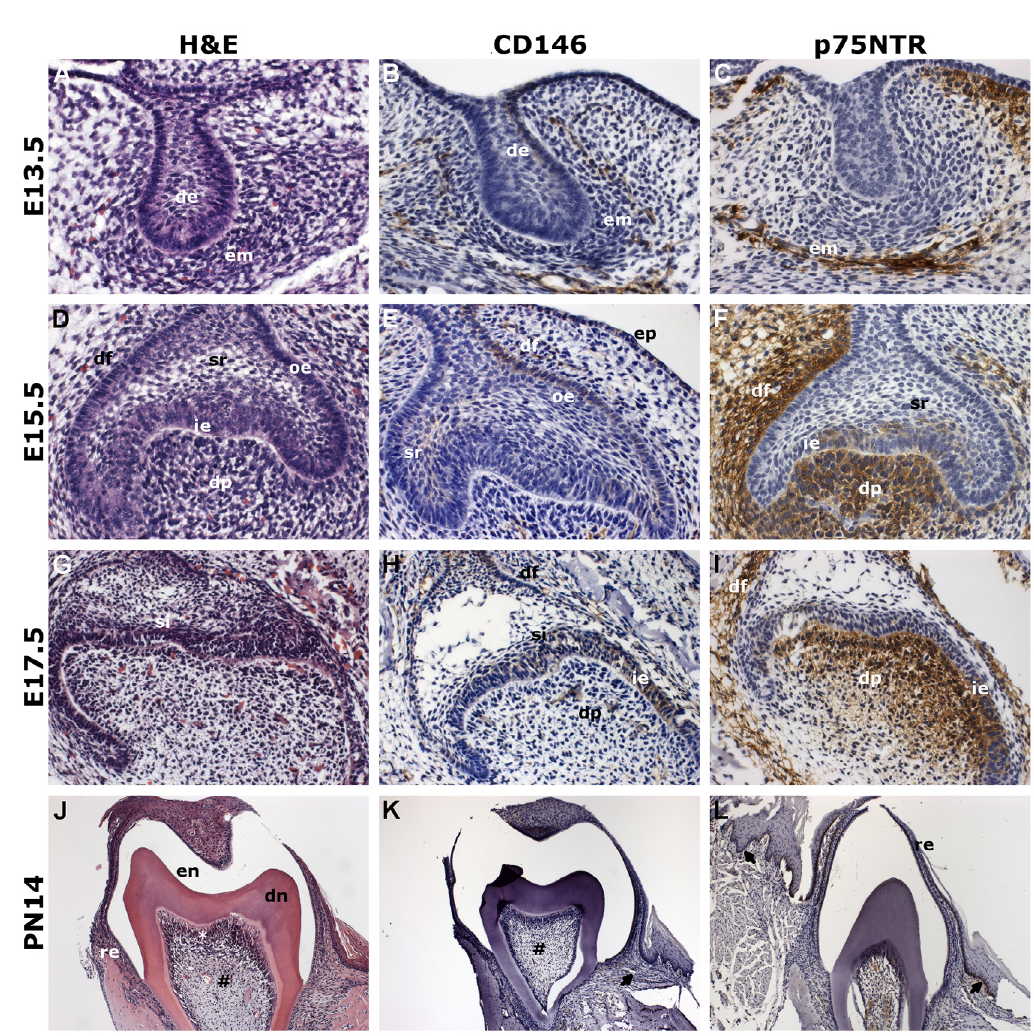
Figure 1- Morphological aspects and CD146 and p75NTR immunoexpression in mice odontogenesis. Rows represent, from top to bottom, the bud (A–C), cap (D–F) and bell (G–I) stages of the tooth germ, and the 14 days postnatal tooth (J–L). (A, D, G, J) show the main morphological characteristics in the different stages. At the bud stage, the immunohistochemical expression of CD146 was detected in the dental epithelium and ectomesenchymal condensation (B). For p75NTR, the immunostaining was restricted to the ectomesenchymal cells (C). At the cap stage, CD146 was found in the outer enamel epithelium, stellate reticulum, dental follicle, and oral epithelium (E). An intense expression of p75NTR was seen in the dental papilla and dental follicle (F). During the bell stage, the CD146 was positive in the inner enamel epithelium, stratum intermedium, dental follicle, and dental papilla (H), and p75NTR was detected in the inner enamel epithelium, dental follicle and dental papilla (I). In the postnatal group, only the dental pulp cells were positive for CD146 (K), while p75NTR immunostaining was seen in the reduced enamel epithelium and oral mucosa epithelium (L). Magnification: A–I, 400× in the original; H–J, 100×